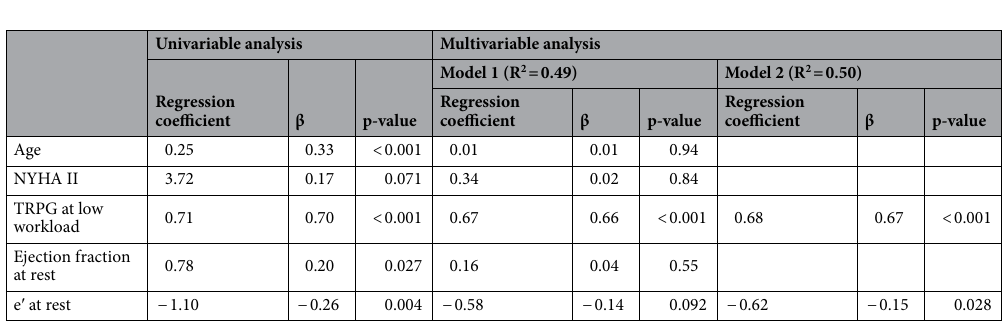
Table 5. Variables associated with TRPG at peak workload. R 2 adjusted coefficient of determination. Model 1 included age, NYHA II, TRPG at low workload, ejection fraction at rest, and e ′ at rest. Model 2 included all variables in Model 1 with stepwise multiple regression analysis. NYHA New York heart association, TRPG tricuspid regurgitation pressure